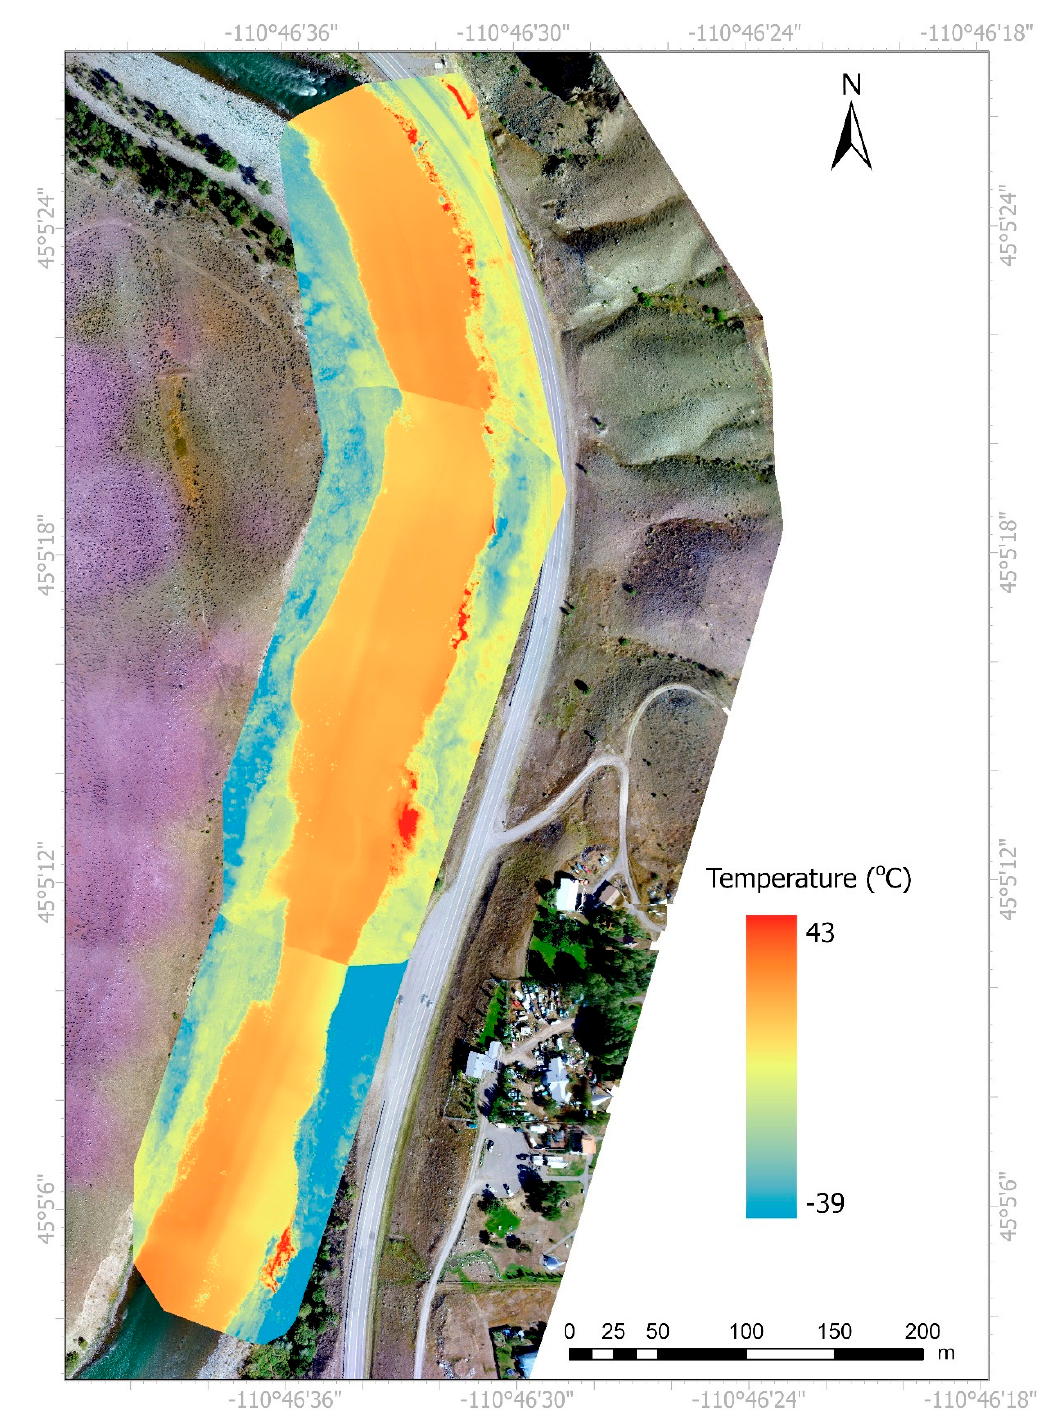
Figure A3. Thermal orthomosaics using transformed thermal data generated in Pix4D Mapper and Georeferenced in ArcPro for September. RGB orthomosaic corresponds to the flight data from September 2019.